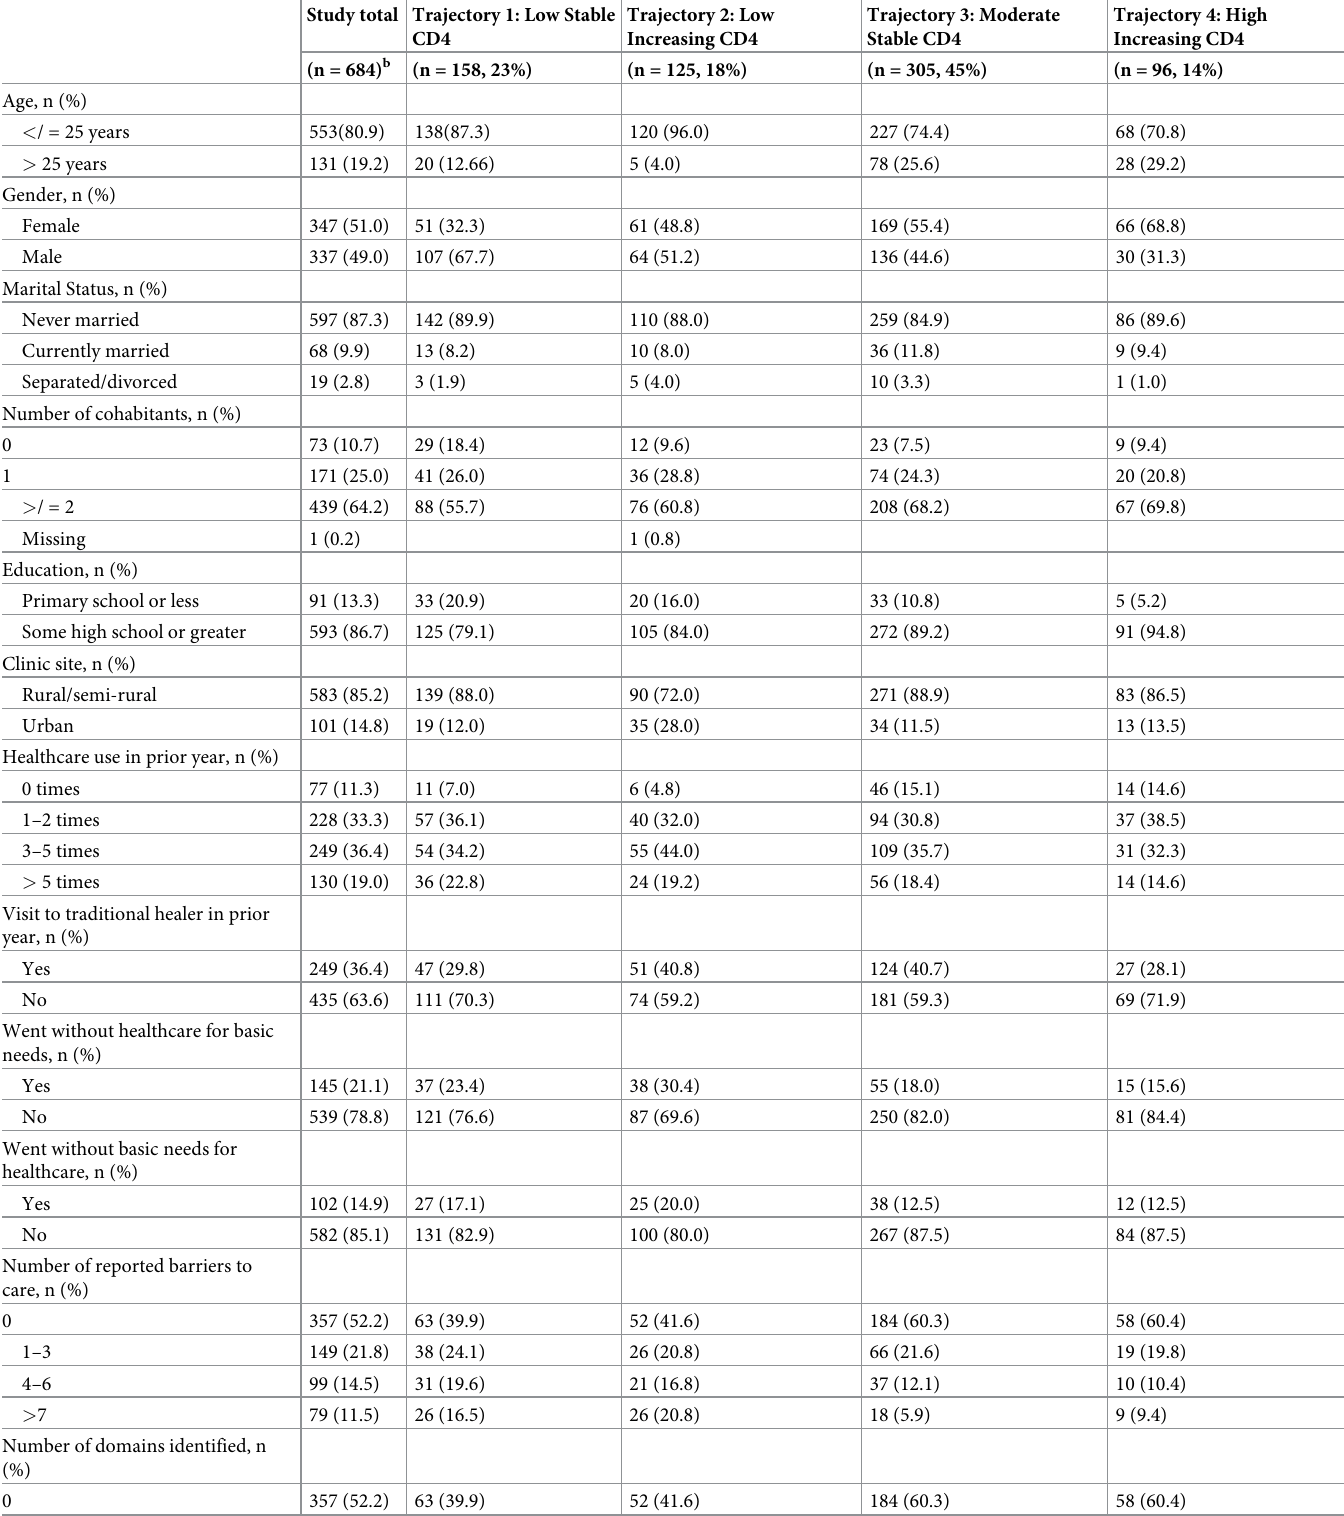
Table 1. Baseline patient characteristics stratified by estimated trajectory group a